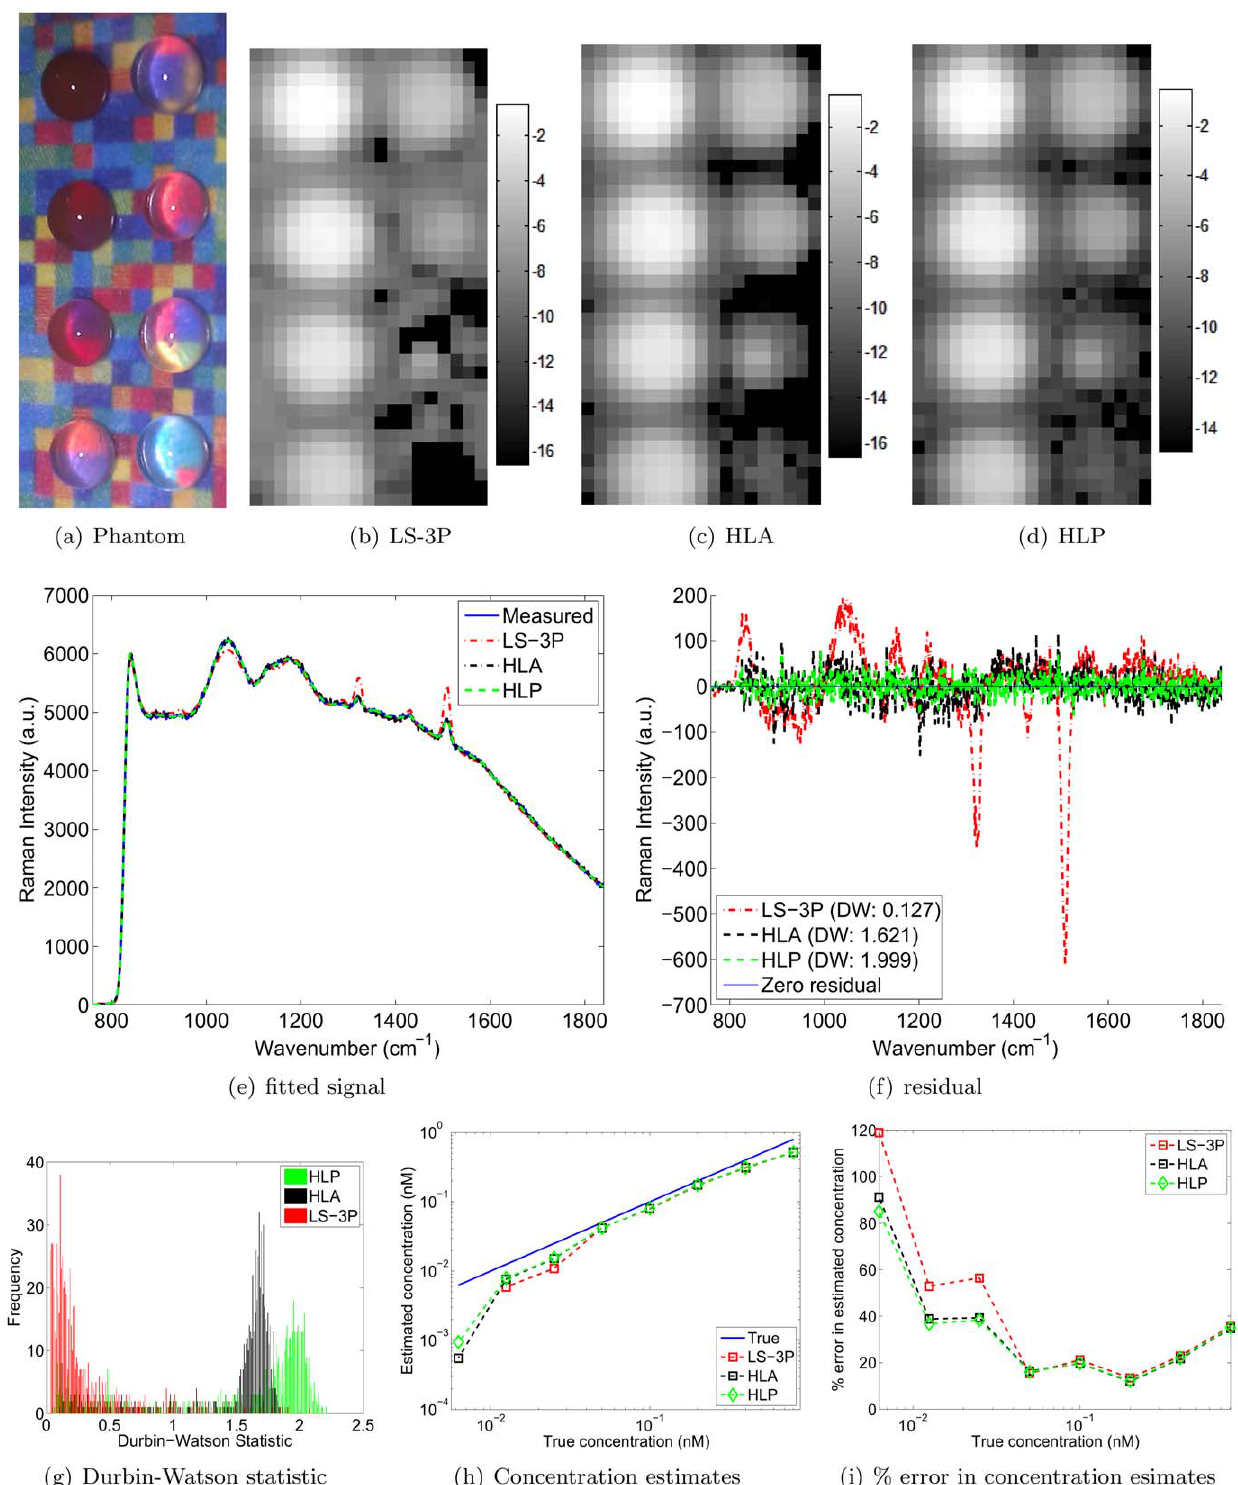
Figure 3. Color background results. (a) Phantom, (b-d) log2 of S440 concentrations by LS-3P, HLA, and HLP, (e-f) example fitted spectra and residuals by LS-3P, HLA and HLP, (g) histogram of the Durbin-Watson statistic for all pixels, and (h-i) quantification of concentration estimation accuracy. ‘True’ in (h) plots the theoretical linear relationship between the estimated and true concentrations of S440. The concentration estimate by LS-3P for the lowest true concentration was negative and hence not shown in the logarithmic plot in (h).